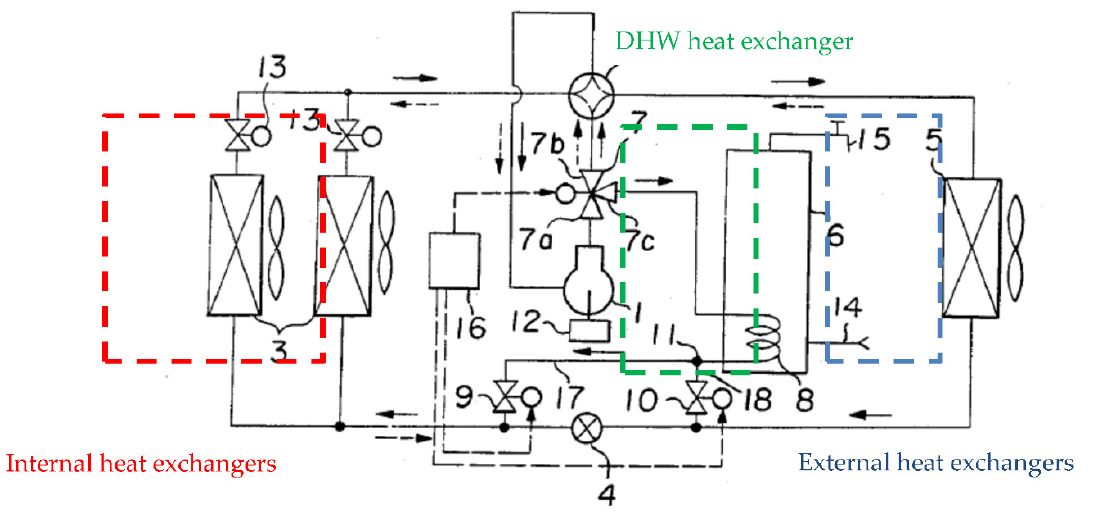
Figure 18. Schematic diagram of the patent of Mitsubishi Denki Kabushiki Kaisha (US4592206).